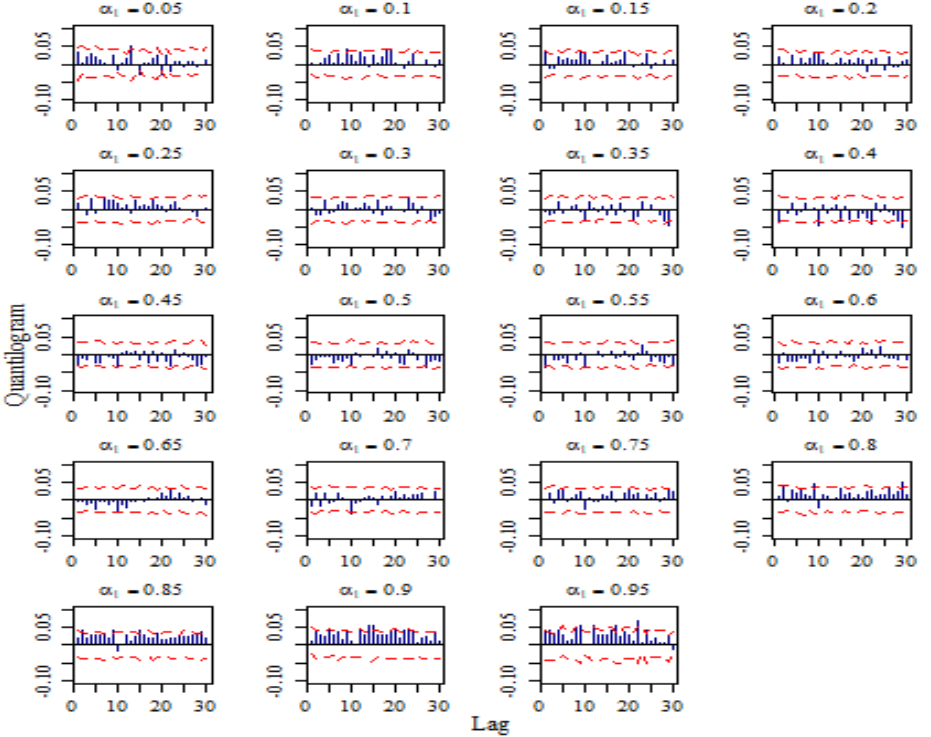
Figure 5. Sample cross-quantilograms, to capture directional predictability from OVX to oil, when both return series are in the same quantiles. See notes to Figure 3.